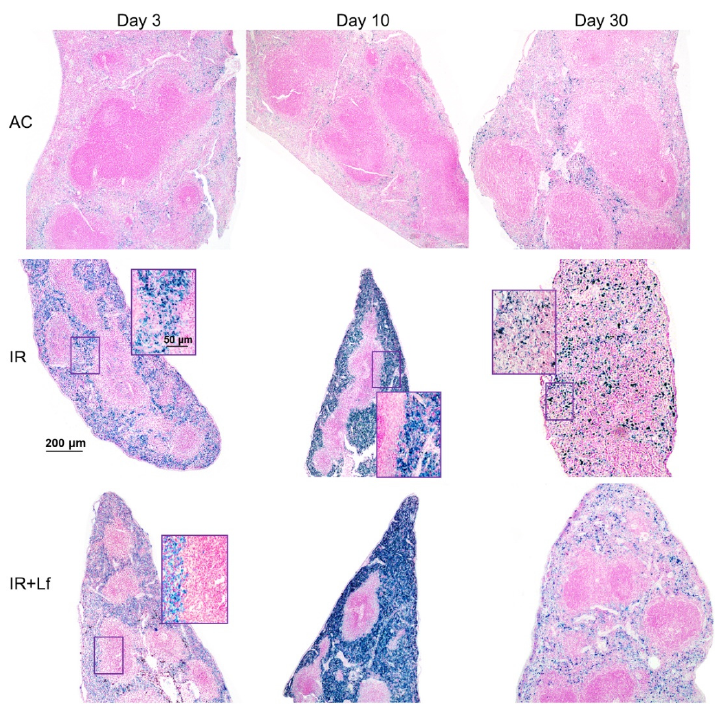
Figure 11. Protective effect of Lf on the structural organization of the spleen in the irradiated mice. Representative photomicrographs of spleen sections on days 3 (left column; n = 5–6 for each group), 10 (middle column; n = 5–6 for each group), and 30 (right column; n = 7–10 for each group) days after 7.5 Gy whole-body gamma irradiation. Groups: AC (sham-irradiated), IR (irradiated), IR+Lf (Lf was administered immediately after irradiation; i.p.; 4 mg/mouse). Pearl’s staining for iron (III). Scale bars = 200 μ m and 50 μ m.